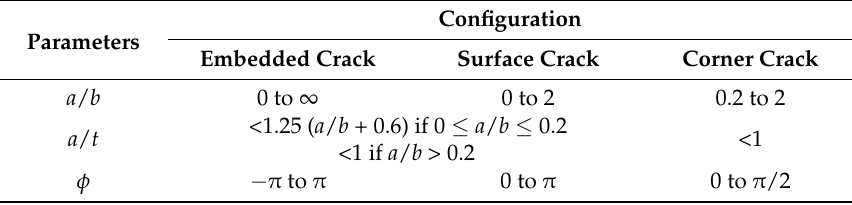
Table 1. Applicability ranges for the equations by Newman and Raju [1].